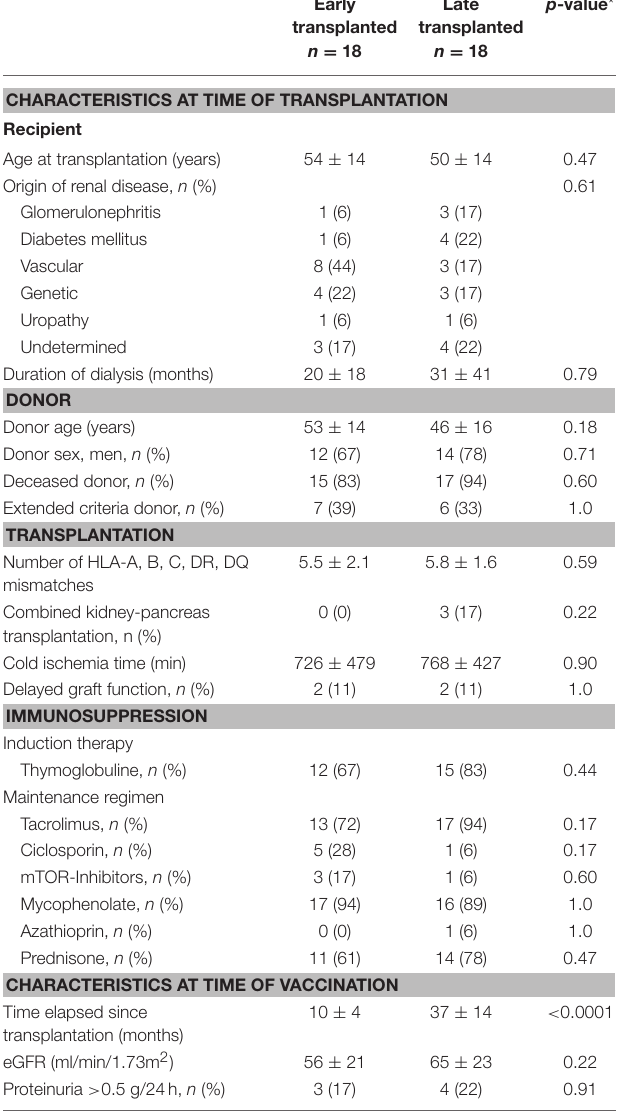
p -value Early Late transplanted transplanted n = 18 n = 18